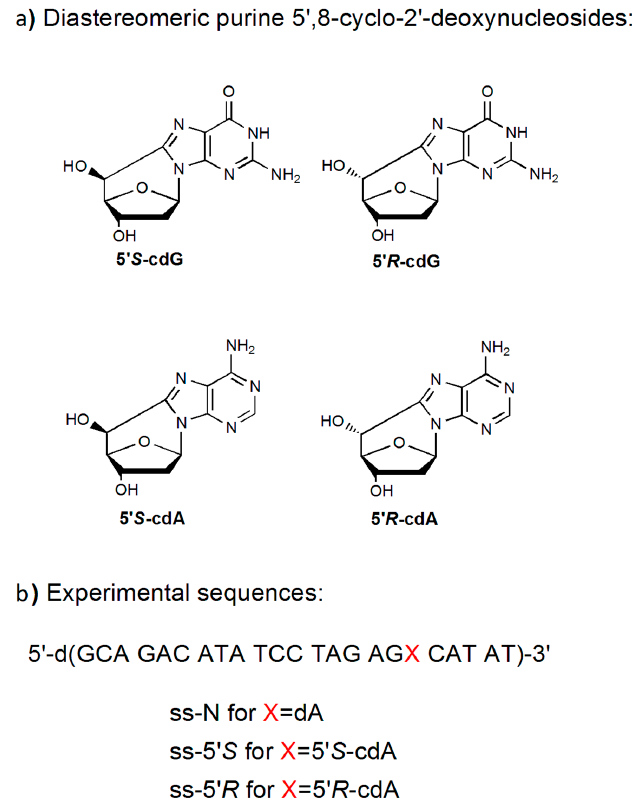
Figure 1. Structures and oligonucleotide sequences. ( a ) Chemical structures of the diastereomeric purine 5’,8-cyclo-2’-deoxynucleosides. ( b ) The sequences of the single stranded (ss) oligonucleotides